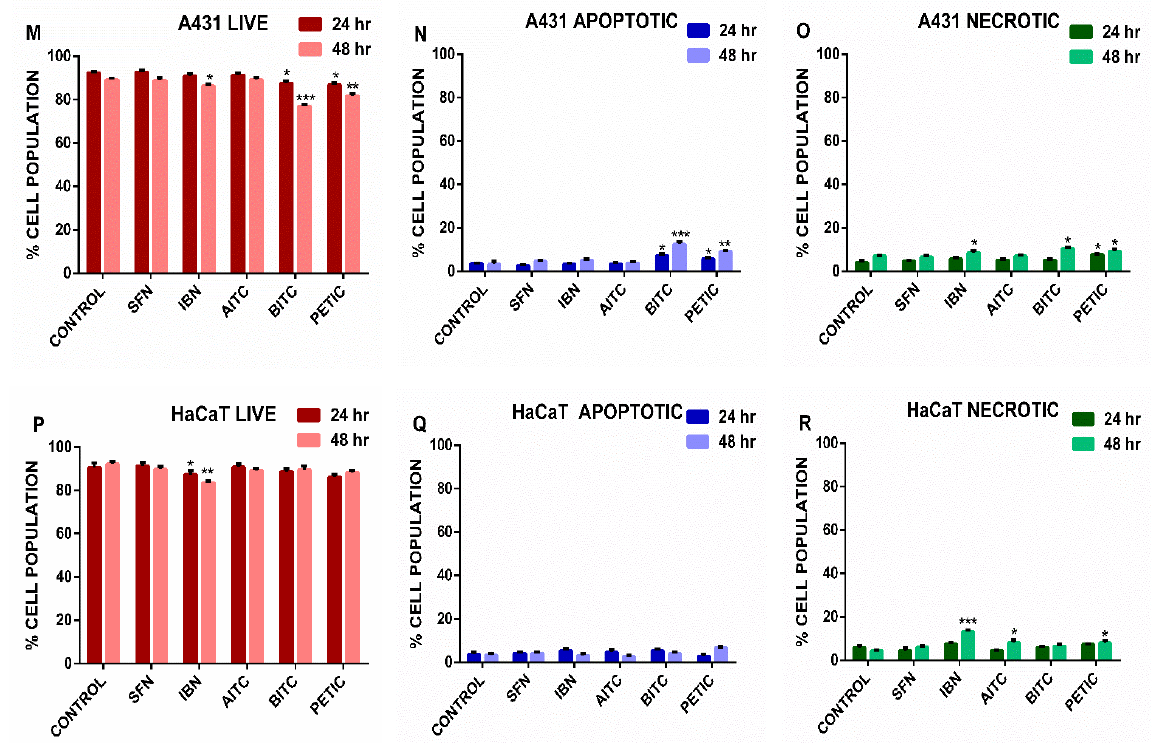
Figure 5. The effect of various ITCs on apoptotic and necrotic cell death in an in vitro model of MM. Cells were exposed to 10 µ M of each ITC, for 24 and 48 h, and monitored by means of flow cytometry. Results were quantitated as percent of live, apoptotic and necrotic cell populations for ( A–C; A375), ( D–F; B16F-10), ( G–I; VMM1), ( J–L; Hs294T), ( M–O; A431), ( P–R; HaCaT) cells. Data shown are means ± SD of three replicates from three independent experiments. * p < 0.05, ** p < 0.01, *** p < 0.001, when compared to untreated (control)